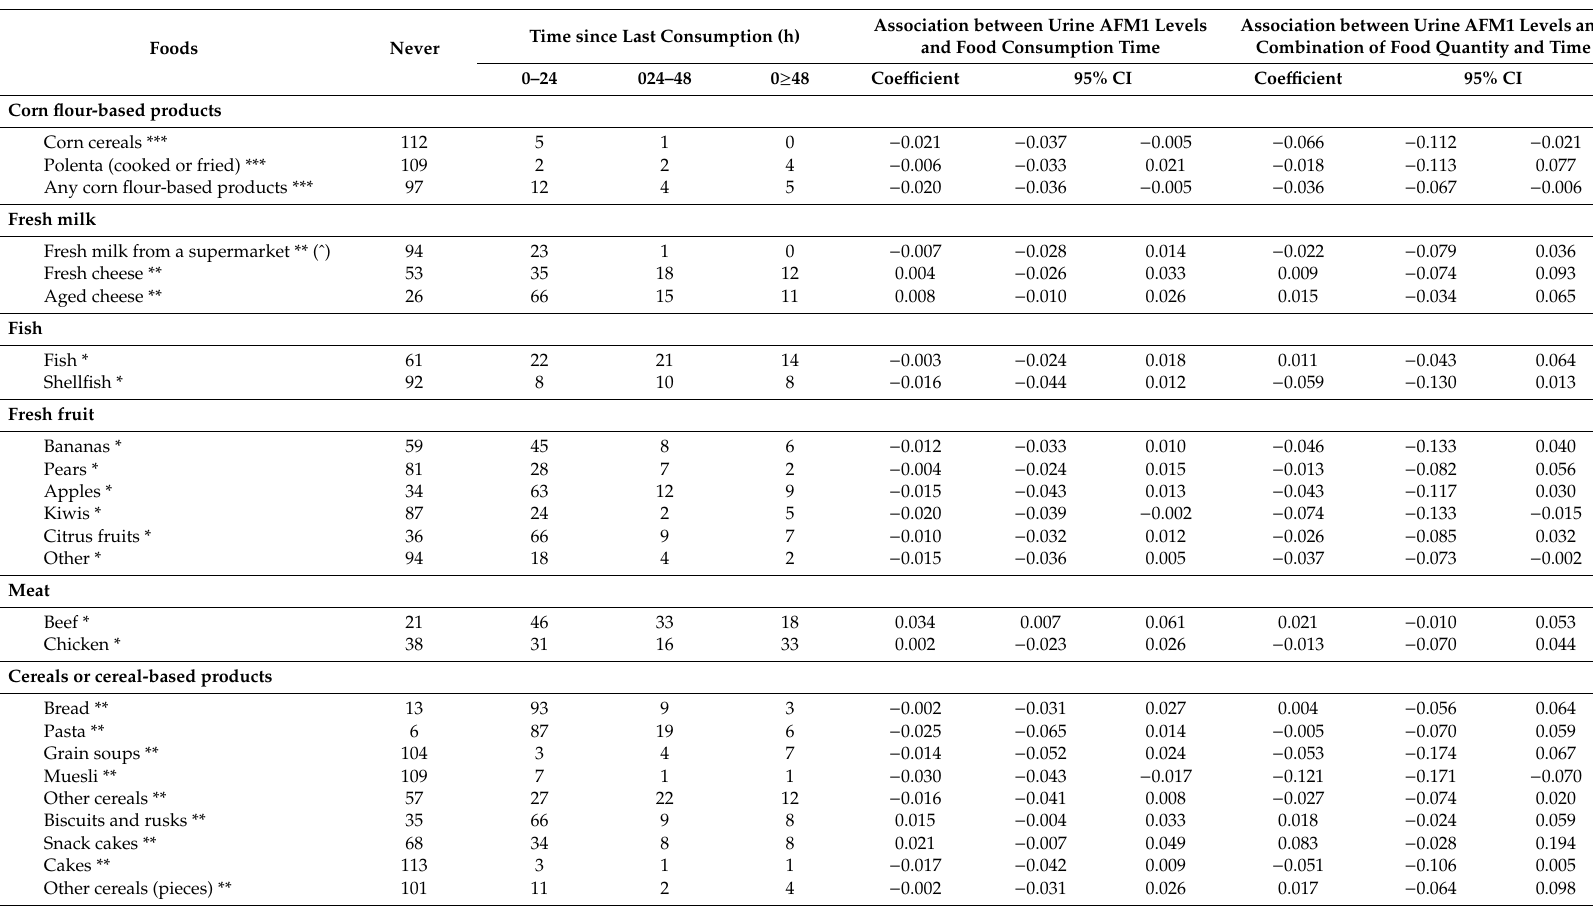
Table 2. The association between urine AFM1 levels and food consumption frequency and combination of food quantity and frequency by kind of food. Association between Urine AFM1 Levels Association between Urine AFM1 Levels and Time since Last Consumption (h) and Food Consumption Time Combination of Food Quantity and Time Foods Never Corn flour-based products Corn cereals ***